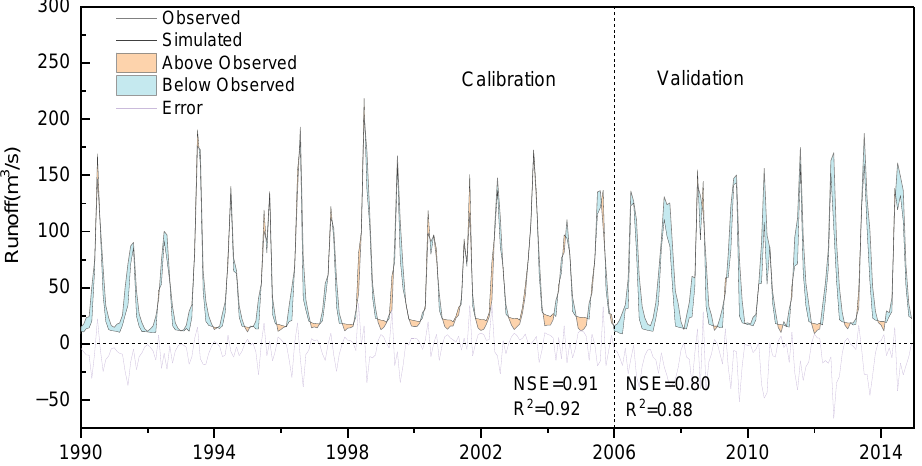
Figure 7. Comparison of observed and simulated monthly runoff during the calibration and validation periods.